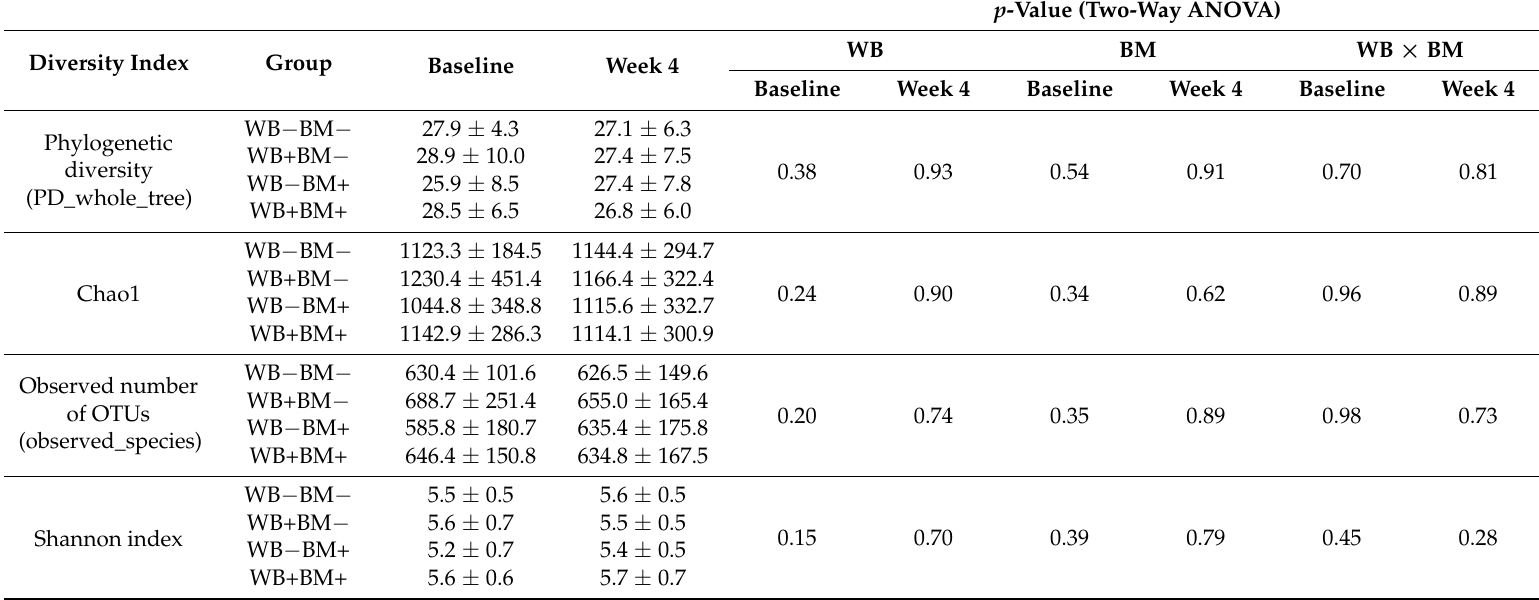
p -Value (Two-Way